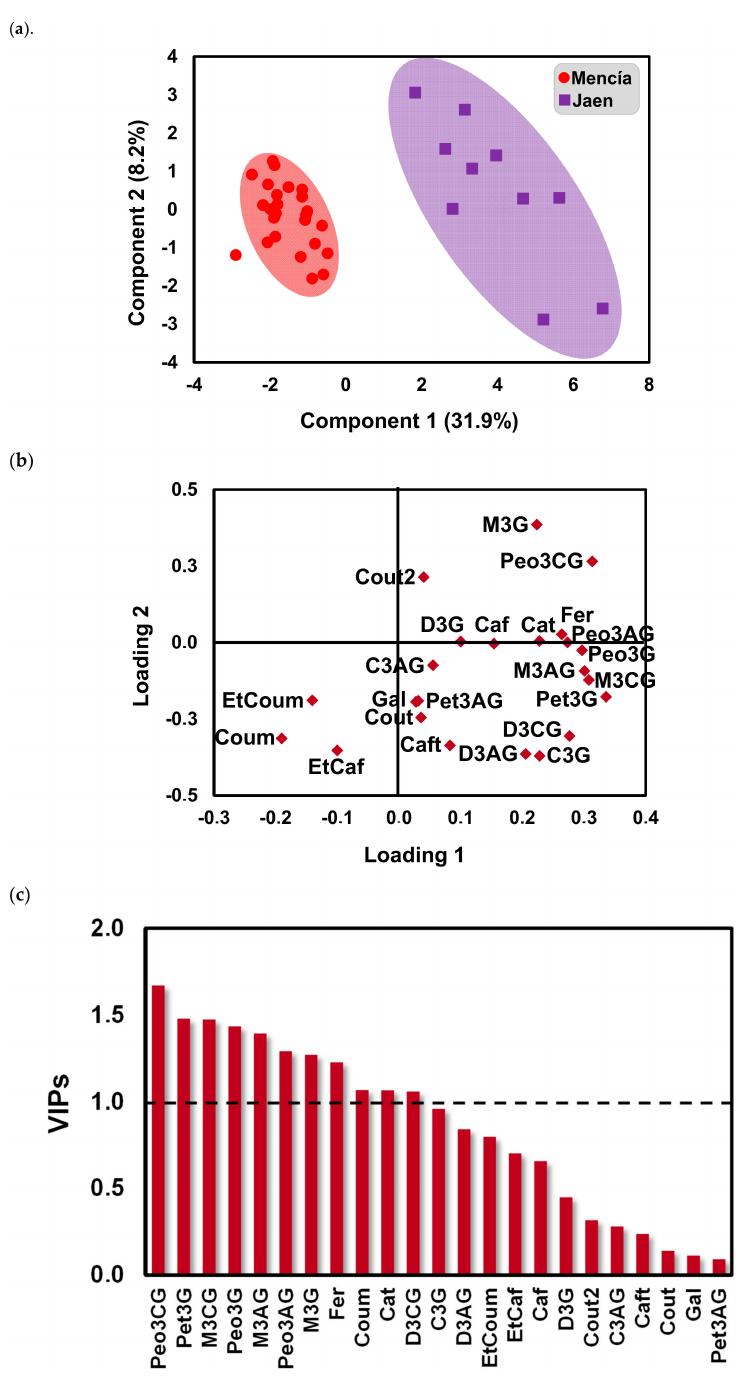
Figure 4. ( a ) Scores plot and ( b ) loadings plot of the first two factors of the Partial Least Squares-Discrimination Analysis (PLS-DA) model built with the phenolic compounds profile of the ‘Menc í a’ / ‘Jaen’ monovarietal wines from the Bierzo D.O. and D ã o D.O., respectively. Phenolic compounds ranked by variable in projection (VIP) scores ( c ). Delphinidin-3-glucoside (D3G), cyanidin-3-glucoside (C3G), peonidin-3-glucoside (Peo3G), petunidin-3-glucoside (Pet3G), malvidin-3-glucoside (M3G), delphinidin-3-acetylglucoside (D3AG), cyanidin-3-acetylglucoside (C3AG), peonidin-3-acetylglucoside (Peo3AG), petunidin-3-acetylglucoside (Pet3AG), malvidin-3-acety lglucoside (M3AG), delphinidin-3-coumaroylglucoside (D3CG), peonidin-3-coumaroylglucoside (Peo3CG), malvidin-3-coumaroylglucoside (M3CG), gallic acid (Gal), caftaric acid (Caft), coutaric acid (Cout), coutaric acid isomer (Cout2), ca ff eic acid (Caf), coumaric acid (Coum), catechin (Cat), ethyl ester of ca ff eic acid (EtCaf), ethyl ester of coumaric acid